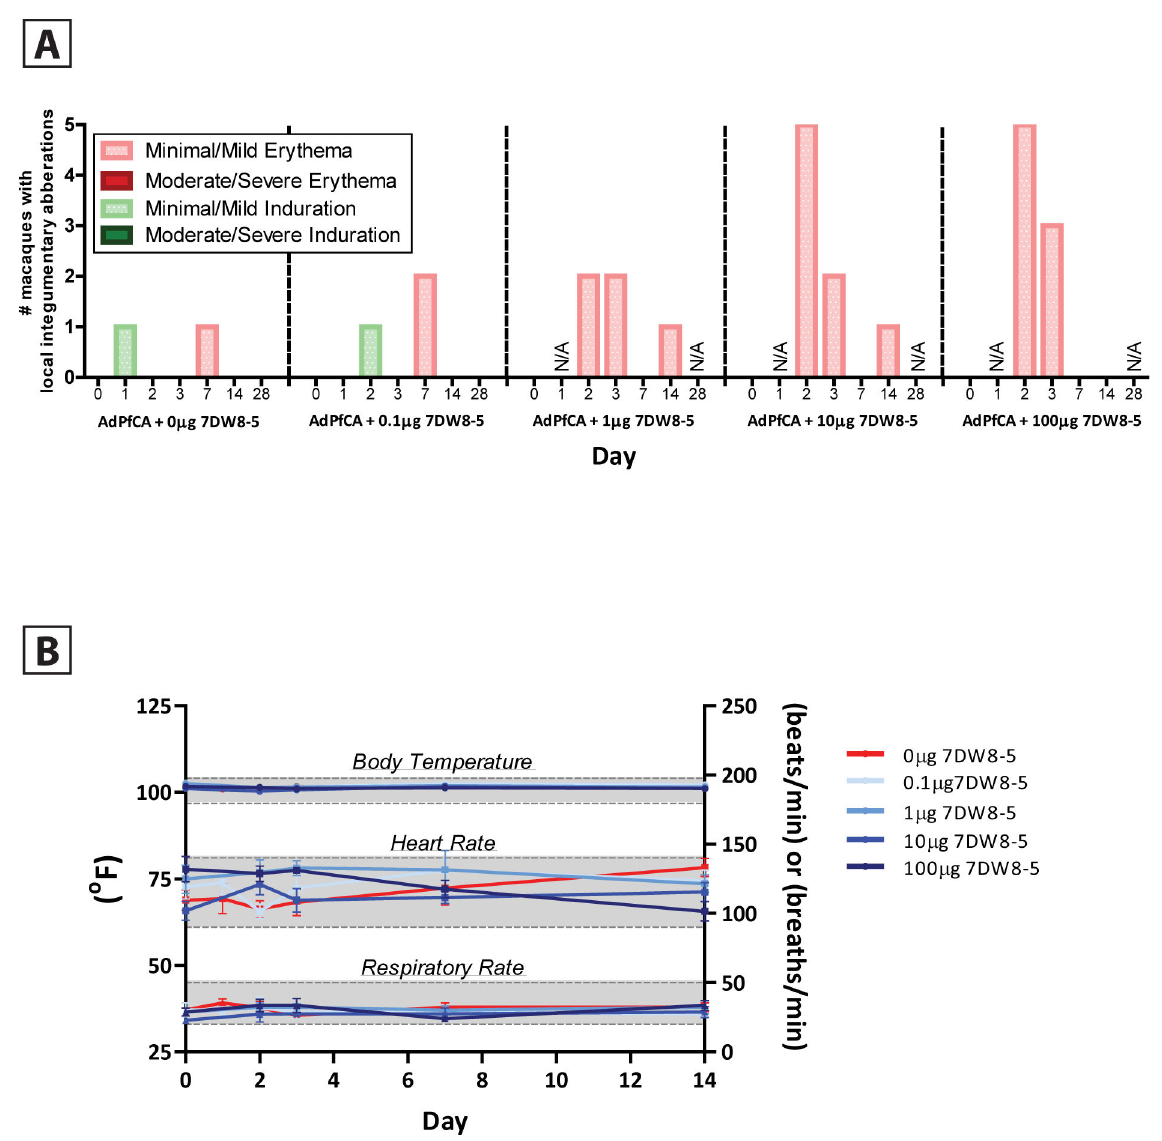
7DW8-5 co-administered with AdPfCA exhibits a favorable safety profile in rhesus macaques. ( A ) Co- administration of 7DW8-5 and AdPfCA induces mild and transient local reactogenicity in vivo . Animals were vaccinated with AdPfCA alone or in combination with escalating doses of 7DW8-5 and observed for induration and erythema at the vaccination site at baseline and up to 28 days post prime. Minimal/mild classification indicates that the reactogenicity covered <1 cm 2 of skin surface area. N/A indicates time points where local reactogenicity was not assessed. ( B ) Co-administration of 7DW8-5 and AdPfCA does not induce systemic reactogenicity in vivo . Animals were monitored for evidence of fever (body temperature, left y-axis), tachycardia (heart rate, right y-axis) and respiratory distress (respiratory rate, right y-axis) at baseline and up to two weeks post prime. Each colored line represents the mean of the indicated 5 animal dose group over time. Error bars indicate SEM, and shaded grey boxes indicate the normal physiological range for each